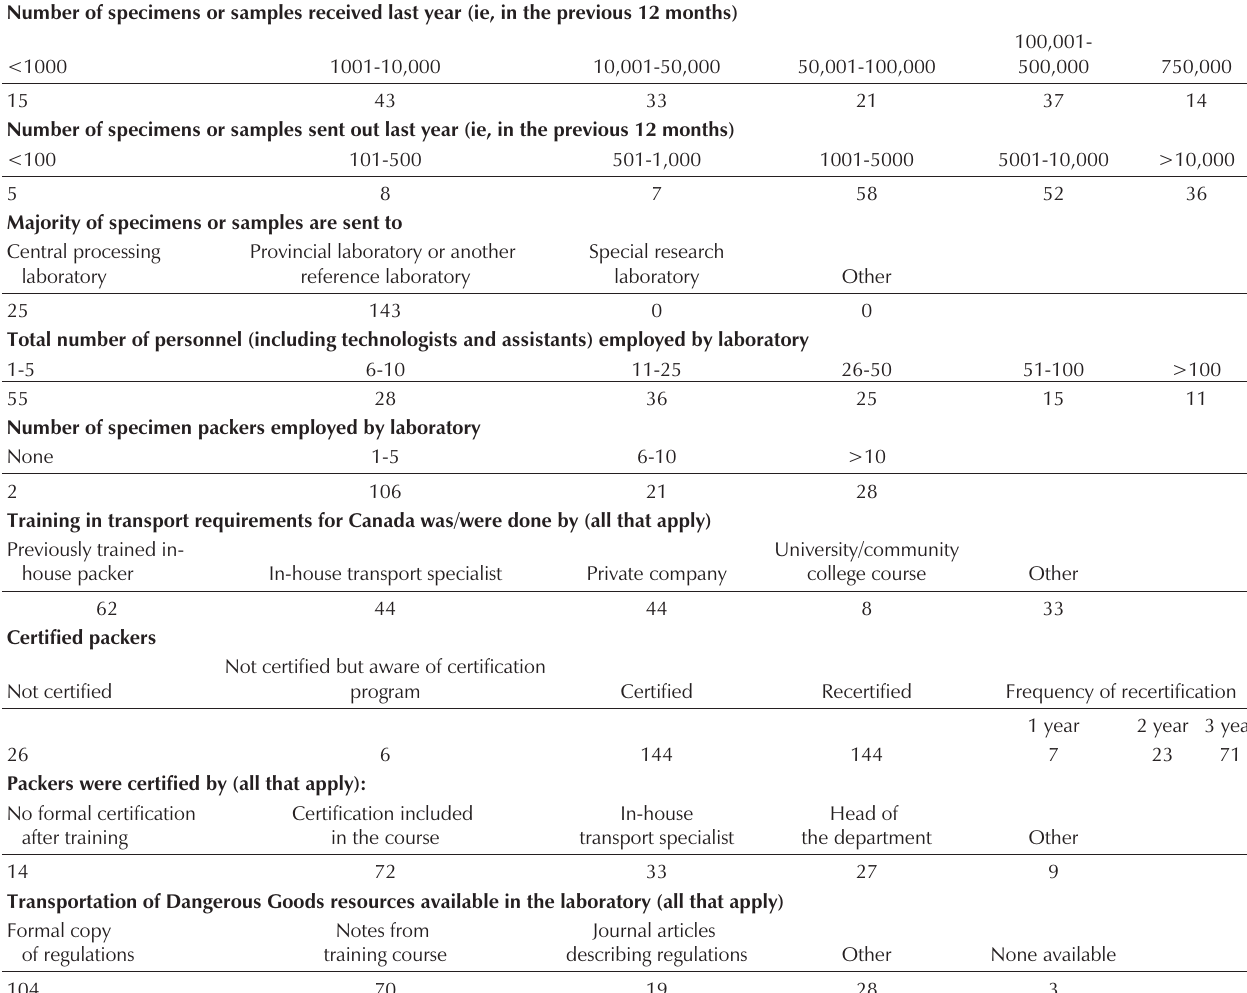
Phase 3 questionnaire results from participants in the Clinical Microbiology Proficiency Testing (CMPT) clinical